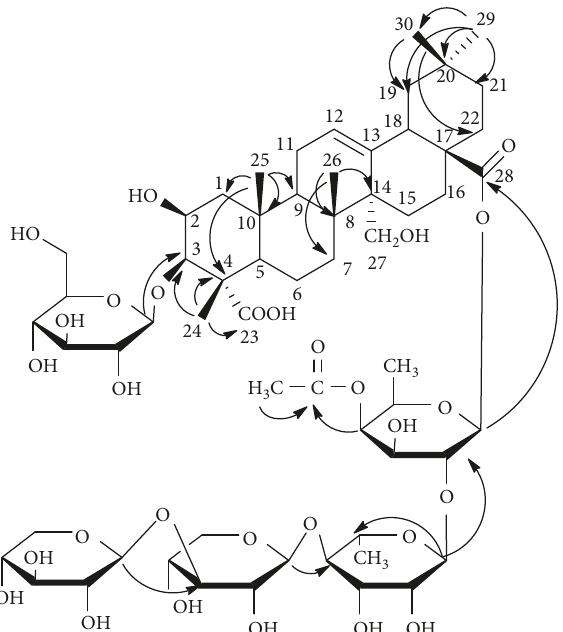
Figure 2: Key HMBC correlations of compound 1 (arrows point from proton to carbon).